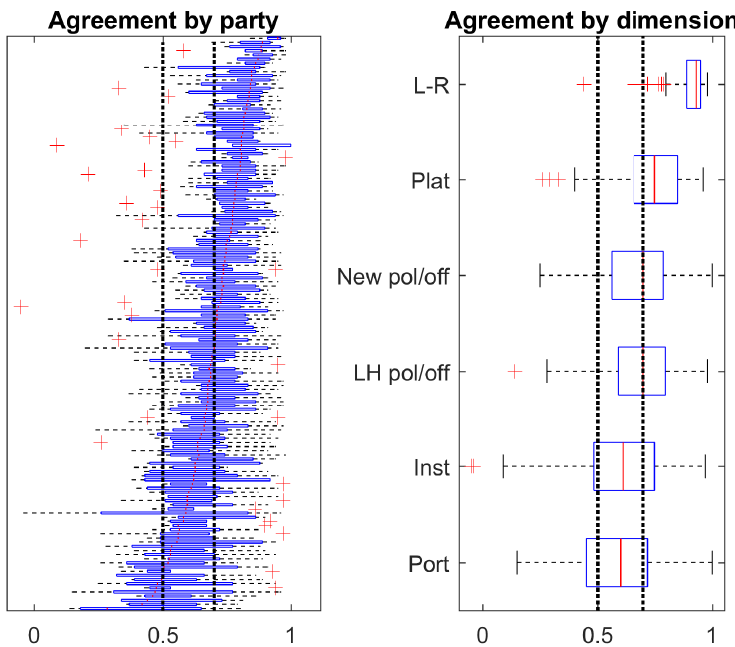
Figure 3. Agreement scores of the experts responses. Table 2. Reliability of the Policy versus Office Goals